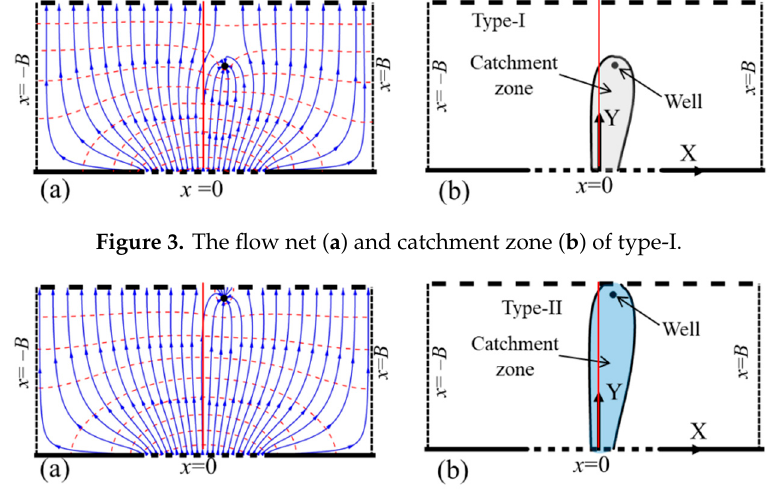
Water 2019 , 11 , x FOR PEER REVIEW Figure 4. The flow net ( a ) and catchment zone ( b ) of type-II. Figure 5. The flow net ( a ) and catchment zone ( b ) of type-III. Figure 4. The flow net ( a ) and catchment zone ( b ) of type-II. Figure 4. The flow net ( a ) and catchment zone ( b ) of type-II.